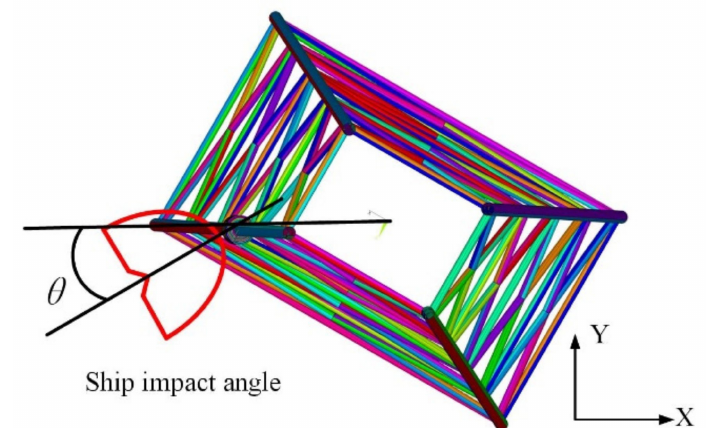
Figure 10. Diagram of the ship impact